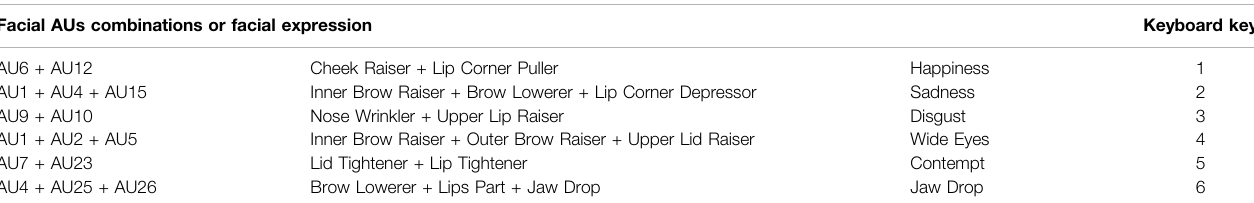
TABLE 1 | Facial AU combinations with their descriptions and their approximate equivalent facial expressions mapped to keyboard keys. Facial AUs combinations or facial